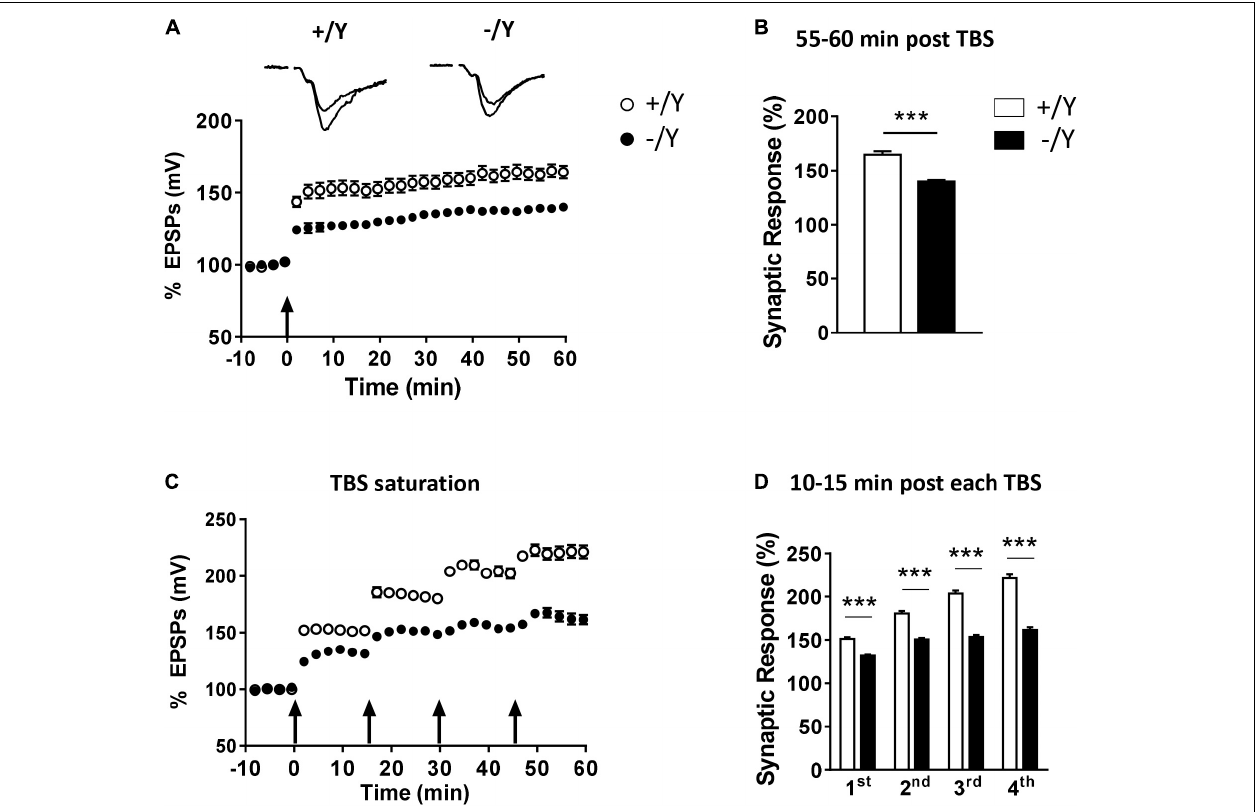
FIGURE 2 | LTP in the perirhinal cortex of Cdkl5 +/Y and Cdkl5 − /Y mice. (A) Amplitude of the synaptic responses evoked before and after theta burst stimulation (TBS; four trains every 15 s, each train comprising 10 bursts of 5 pulses at 100 Hz, inter-burst interval 150 ms). Here and in the following panels (B–D) , the amplitude of the responses is expressed as a percentage of the average amplitude of responses recorded 10 min before LTP induction. Here, and in panel C, the arrows indicate the time of delivery of the TBS. The traces at the top are examples of responses recorded before, and 55–60 min after, LTP induction. (B) The histograms indicate the averaged amplitude of the responses recorded 55–60 min after TBS. Same data as in (A) . Recordings were carried out in slices from P50 Cdkl5 +/Y ( n = 9; 5 animals) and Cdkl5 − /Y ( n = 11; 9 animals) mice. (C) Amplitude of the synaptic response evoked before and after four consecutive TBS stimulations delivered at 15-min intervals. (D) The histograms indicate the averaged amplitude of the responses recorded 10–15 min after each TBS. Same data as in (C) . Recordings were carried out in slices from P50 Cdkl5 +/Y ( n = 7; 7 animals) and Cdkl5 − /Y ( n = 7; 7 animals) mice. ∗∗∗ p < 0.001 (Student’s two-tailed t -test).